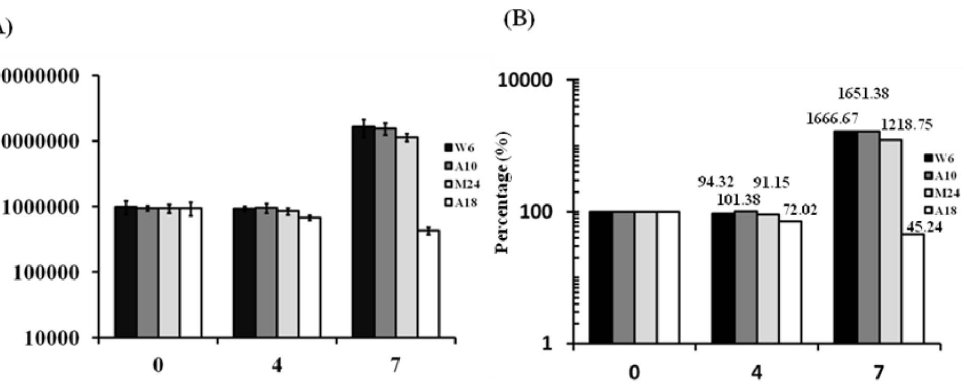
Figure 3. Poor survival of an EAI strain compared to Beijing strains in MDM. MDM were infected with different M. tuberculosis strains at a multiplicity of infection of 1:1 (bacterium to MDM ratio). The non-adhering bacteria were then eliminated with three washes with PBS. At specific time-points the bacterial uptake by MDM was determined by lysing a fraction of the cells with 0.1% saponin and counting the diluted cell lysates by plating. The results are presented as CFU (A) or percent survival relative to day 0 (B).